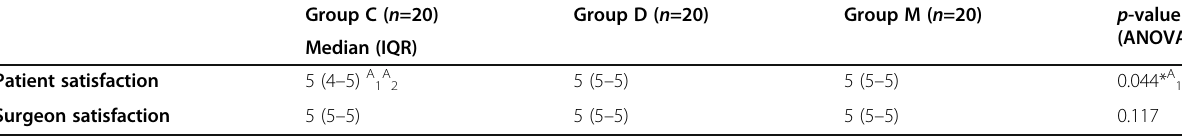
Table 4 Comparison between the three groups regarding the satisfaction